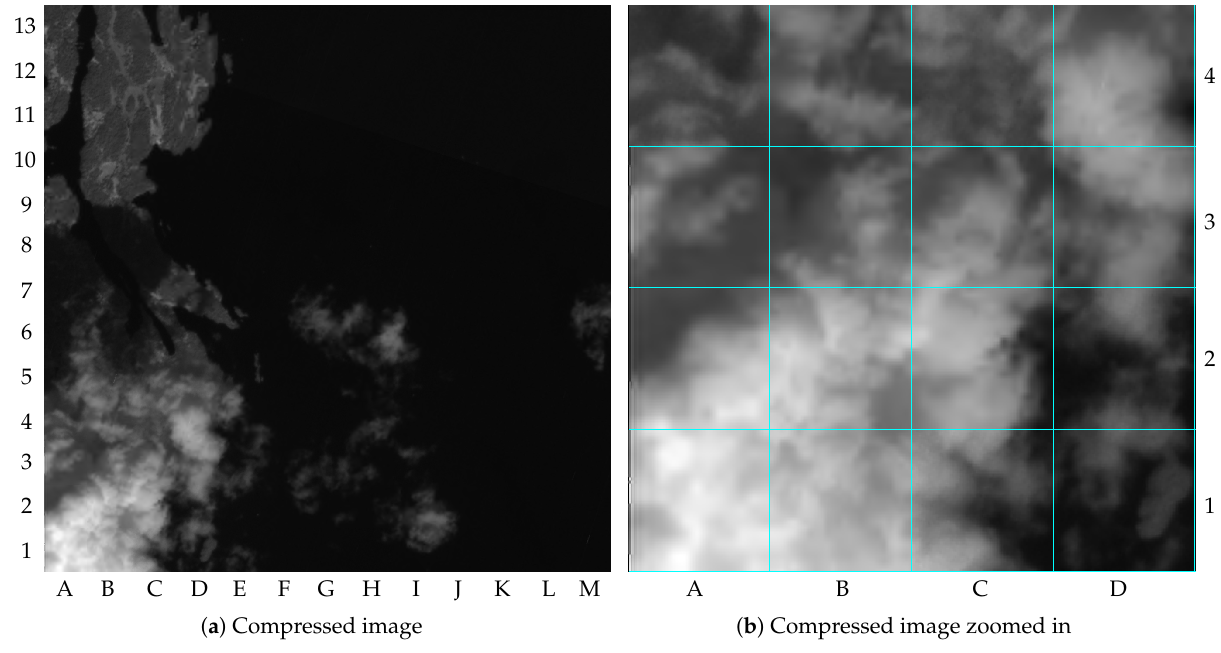
Figure 12. NIR band of the image 9 compressed with the proposed method: ( a ) compressed image; ( b ) compressed image zoomed